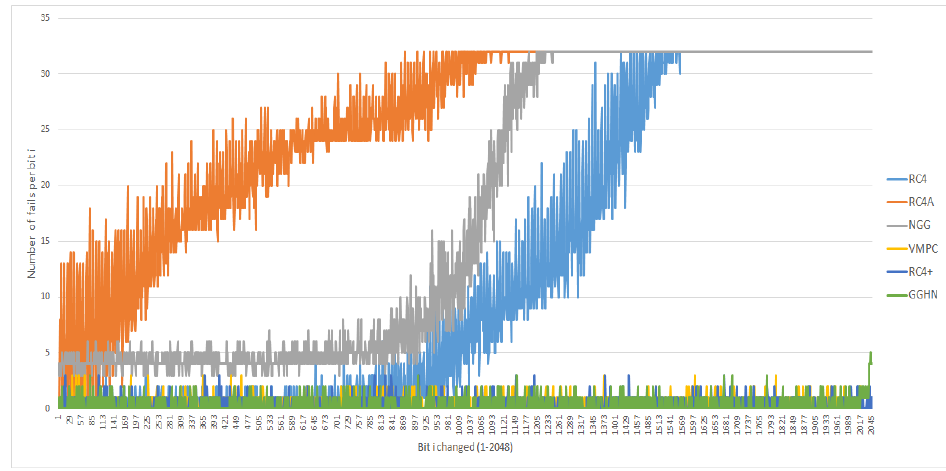
Figure 1. Distribution of the fails per bit changed in SAC for n = 2048, m = 32, and l = 16,384.